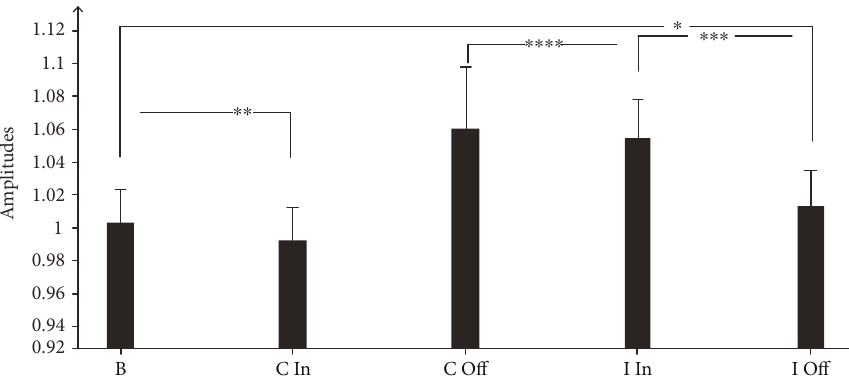
Figure 4: Paired-associative stimulation (PAS)-induces plasticity. PAS e ff ects in sessions B, C In, C O ff , I In, and I O ff were assessed by the average of motor-evoked potential (MEP) amplitudes at time points Before (B), Contralateral Acupuncture In (C In), Contralateral Acupuncture O ff (C O ff ), and Ipsilateral Acupuncture In (I In), Ipsilateral Acupuncture O ff (I O ff ) normalized to the baseline. All data are mean ± SD of nine participants. The asterisks indicate the statistical signi fi cance (one-way repeated measure